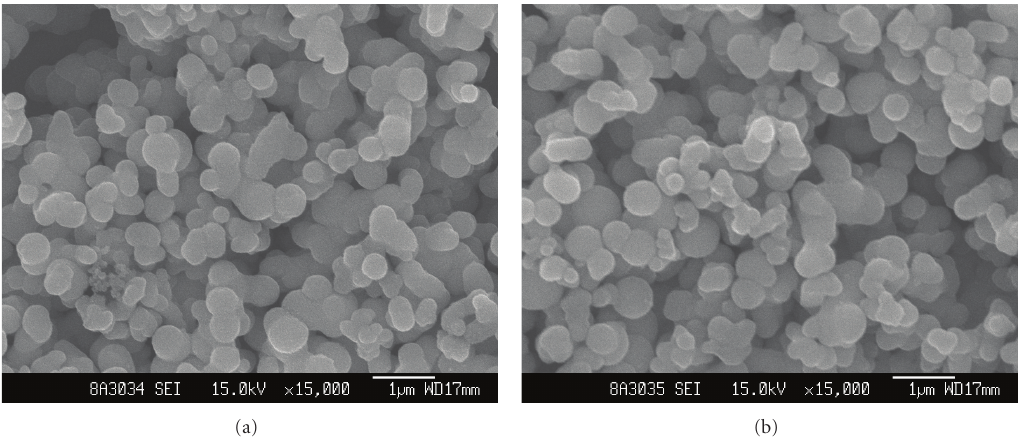
Figure 1: Scanning electron micrograph of TiO 2 (a) and APTMPP-MPS-TiO 2 (b).